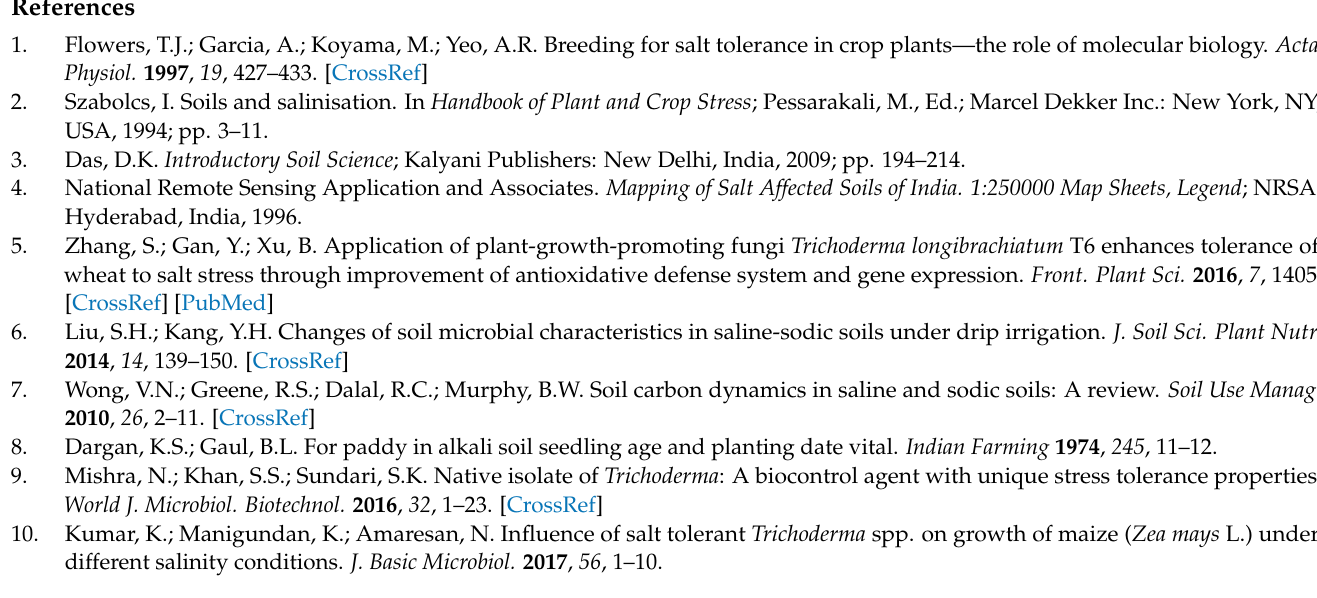
Table S2: Salt tolerance (NaCl) and biochemical properties of selected strains used in this